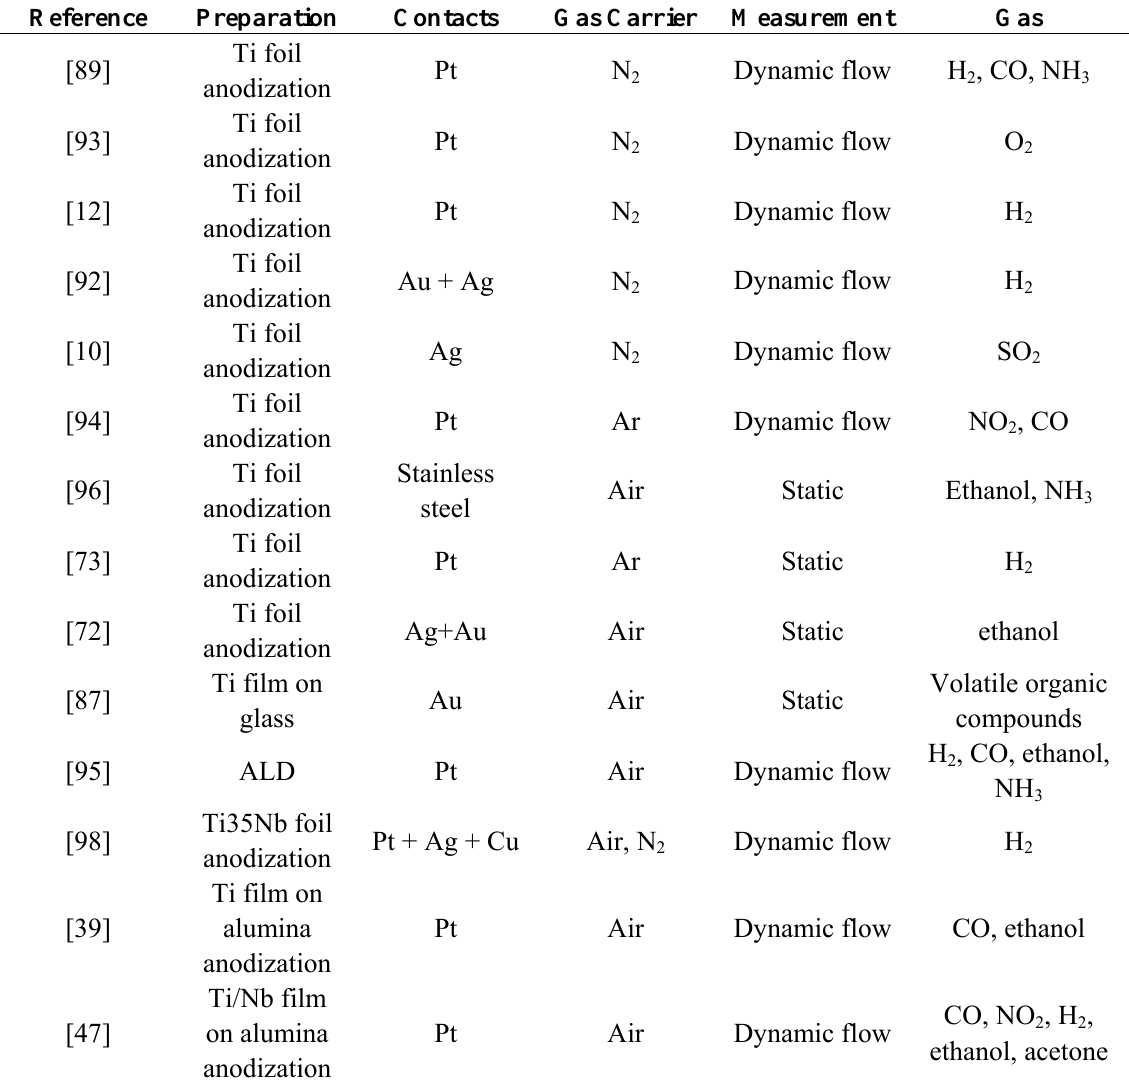
Table 3. List of the selected reference on chemical sensor based on titania nanotubes.